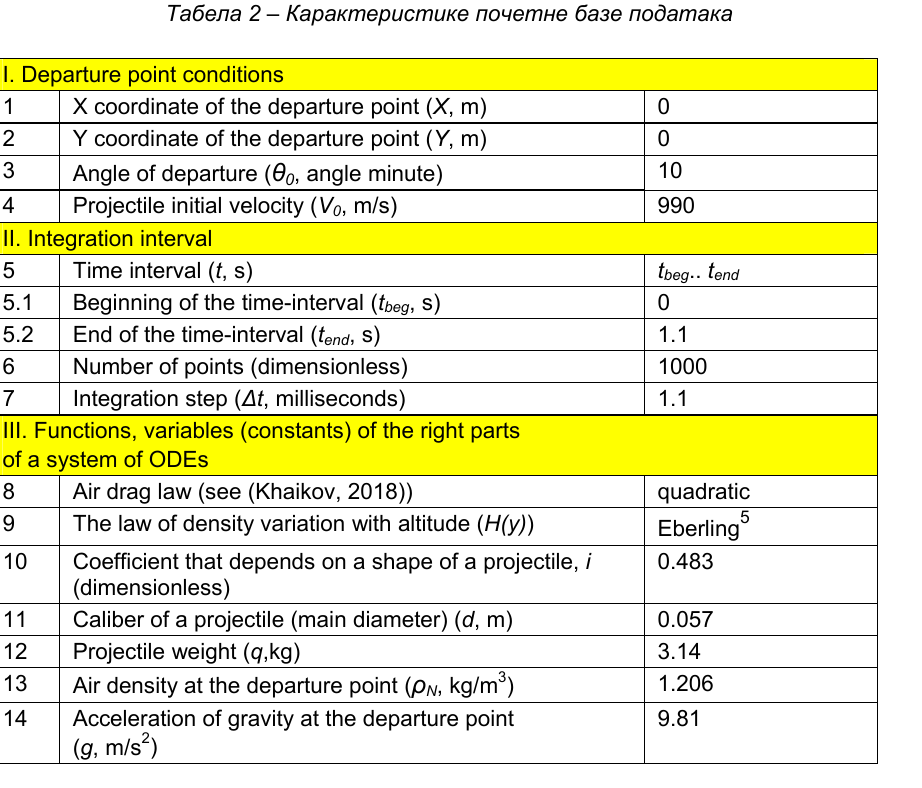
Таблица 2 – Характеристика исходных данных Табела 2 – Карактеристике почетне базе